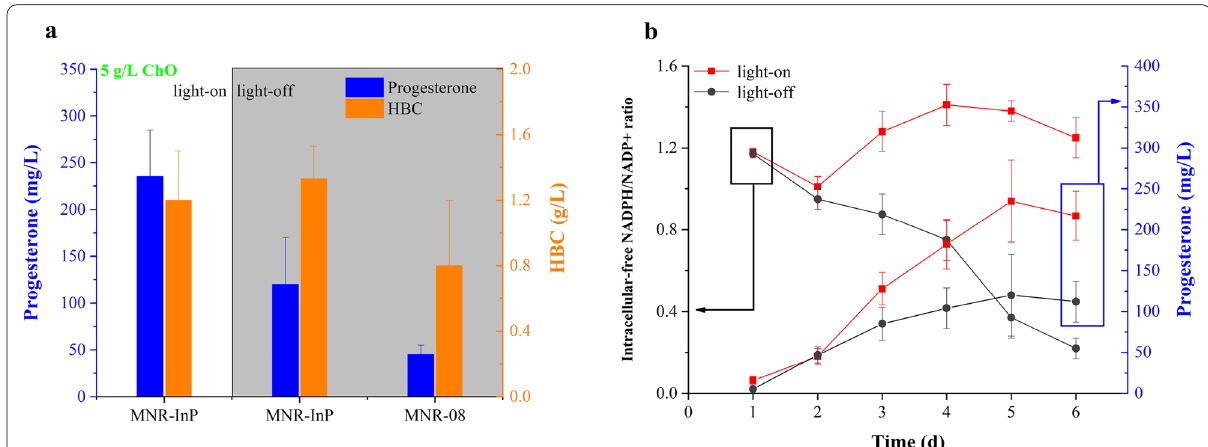
Fig. 7 Improved progesterone production by light‑driven NADPH regeneration. a Comparison of steroid titers in MNR‑InP biohybrids and (MNR‑08)‑only resting conversions for 5 days in the flasks with light‑on and light‑off conditions. b Cytosolic‑free NADPH regeneration and progesterone production profiles in light‑on and light‑off